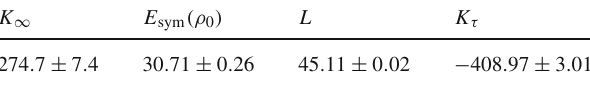
Table 1 Results of present calculations for n = 2 matter incompressibility K ∞ , nuclear symmetry energy at saturation density E sym (ρ 0 ) , the slope L and the isospin dependent part K τ of the isobaric incompressibility (all in MeV) [54,55] are tabulated